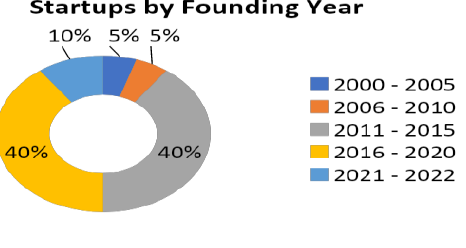
Figure 1: Year startups were